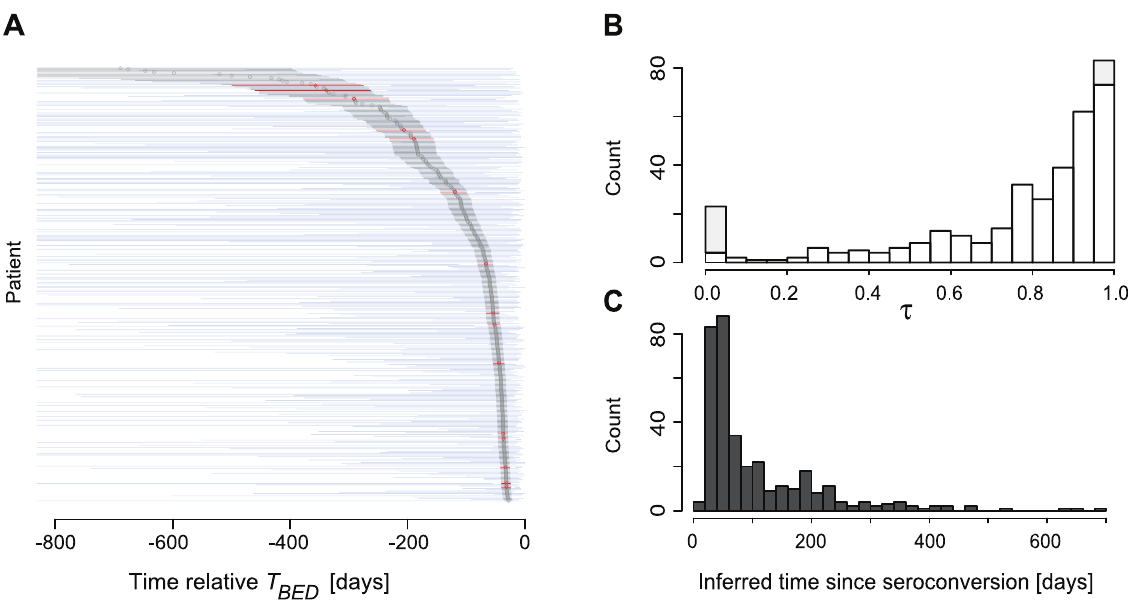
Figure 3. Comparison of inferred time since seroconversion to serological interval. ( A ) The model-inferred time since seroconversion [grey circles with 95% confidence interval as grey lines] from 350 Swedish patients was compared to their known serological intervals [( T ( + ) ,T ( 2 ) ), blue lines]. When the inferred time since seroconversion did not hit the serological interval, the point estimate and 95% confidence interval is marked in red; 94% of the intervals overlapped. ( B ) The relative positioning parameter t measures the normalized position of the inferred time since seroconversion to the serological interval. Values outside this interval are shown in grey at t =0 and t =1. The relative positioning was biased towards the most recent positive HIV test result at large t . ( C ) Distribution of the inferred time since seroconversion, i.e., the times between BED tests and t -corrected dates of seroconversion.